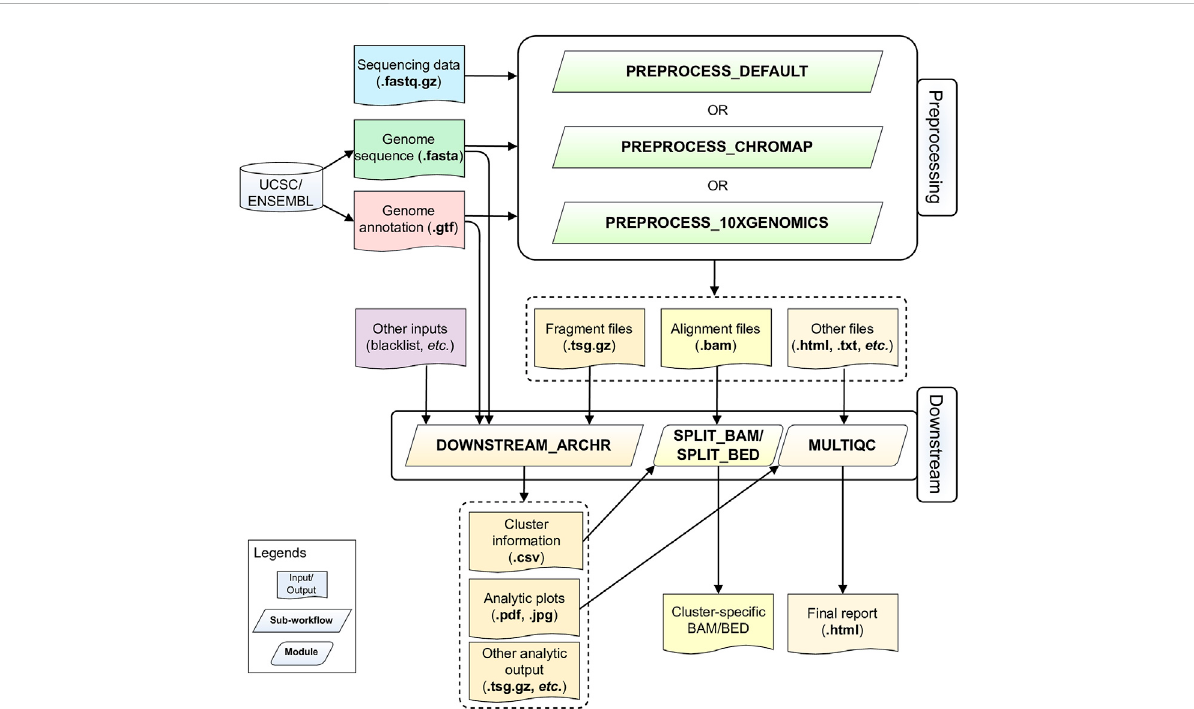
FIGURE 1 Schematic diagram of the scATACpipe work fl ow. The scATACpipe work fl ow is mainly composed of modules for the preprocessing sub- work fl ow and the downstream analysis sub-work fl ow. The preprocessing sub-work fl ow offers three options: the 10x Genomics Cell Ranger ATAC software-based preprocessing, the ultra-fast Chromap-based preprocessing, and the default preprocessing which implements the current best practices for scATAC-seq data analysis. The preprocessing sub-work fl ow takes sequencing data (.fastq.gz fi les), a reference genome sequence (.fasta fi le), and a genome annotation fi le (.gtf fi le) as inputs. The last two fi les can be automatically downloaded from the UCSC or Ensembl Genome Browser. Alternatively, users can specify a genome index compatible with the mapper of the desired preprocessing option. The fragment fi le generated from the preprocessing sub-work fl ow is passed along with an optional genome blacklist fi le and other custom inputs to the downstream analysis sub-work fl ow for core analyses, including batch correction, clustering, integration with scRNA-seq data, cluster annotation, peak calling, markergeneandmarkerpeakidenti fi cation,motifenrichmentanddeviationanalysis,footprintinganalysis,integratedanalysis,andtrajectoryanalysis using mainly the ArchR package. The alignment fi le (.bam) and fragment fi le (.tsv.gz) from the preprocessing sub-work fl ow are converted into cluster-speci fi c BAM, BED, and/or BigWig fi les for visualization in genome browsers. An interactive HTML report is generated at the end with all analytic plots from the downstream analyses, and QC summaries from the default preprocessing sub-work fl ow if